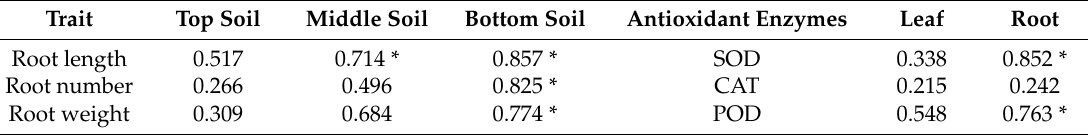
Table 5. Correlation analysis of DRO1 with root distribution and antioxidant